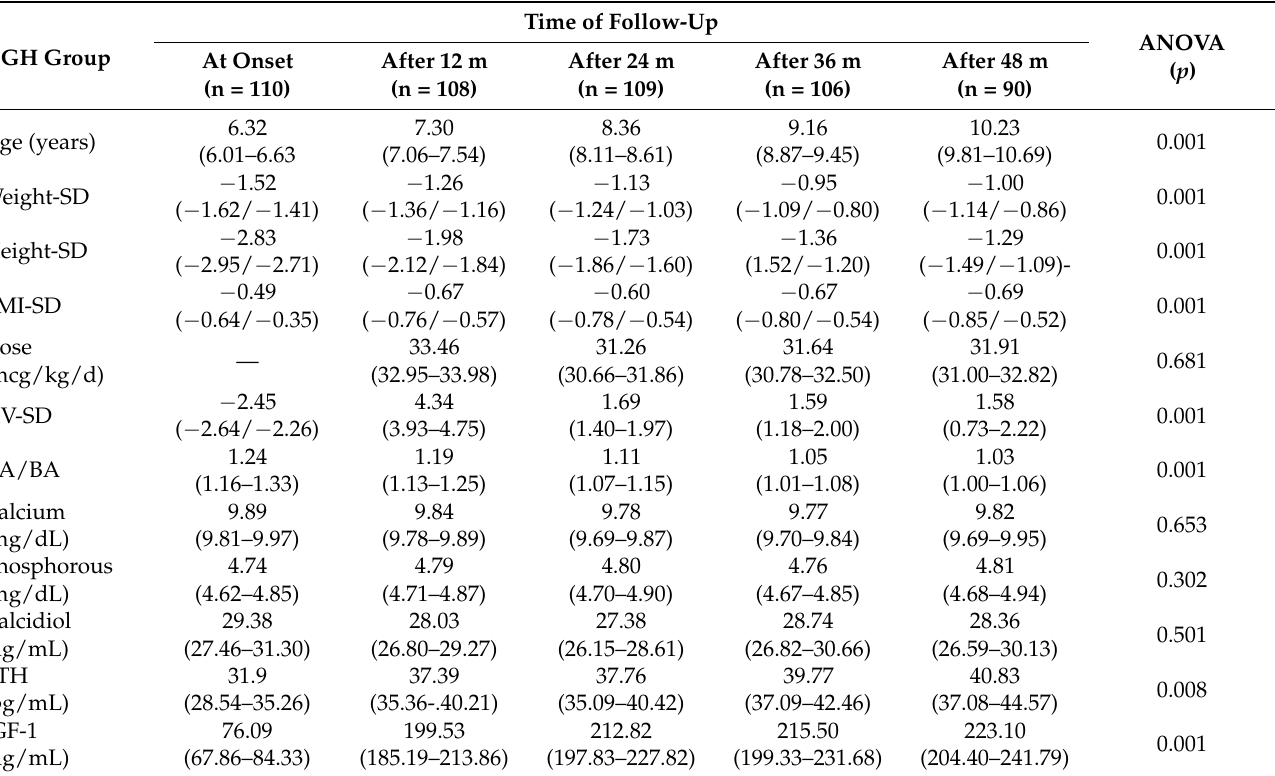
Table 2. Clinical and biochemical features in the GHD group at diagnosis and along the treatment with rhGH (M, 95% CI).